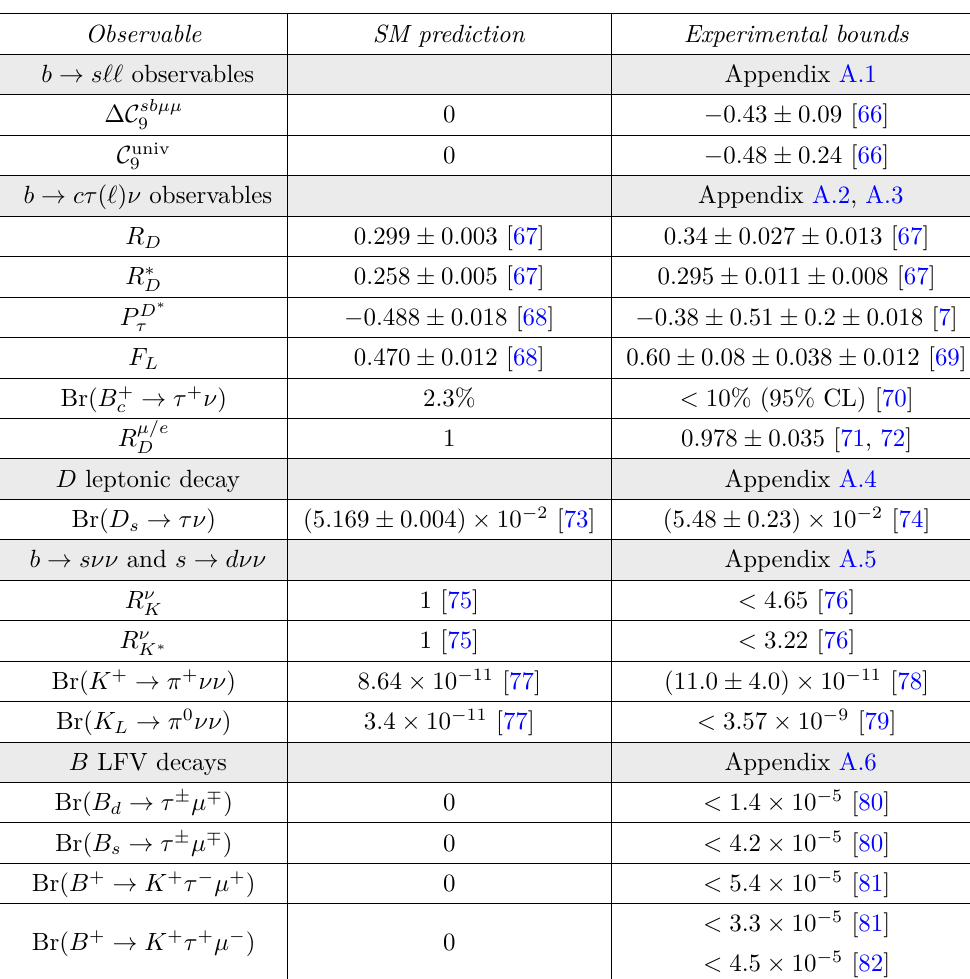
Table 1 . Low-energy semileptonic observables with their SM predictions and experimental bounds. Upper limits correspond to